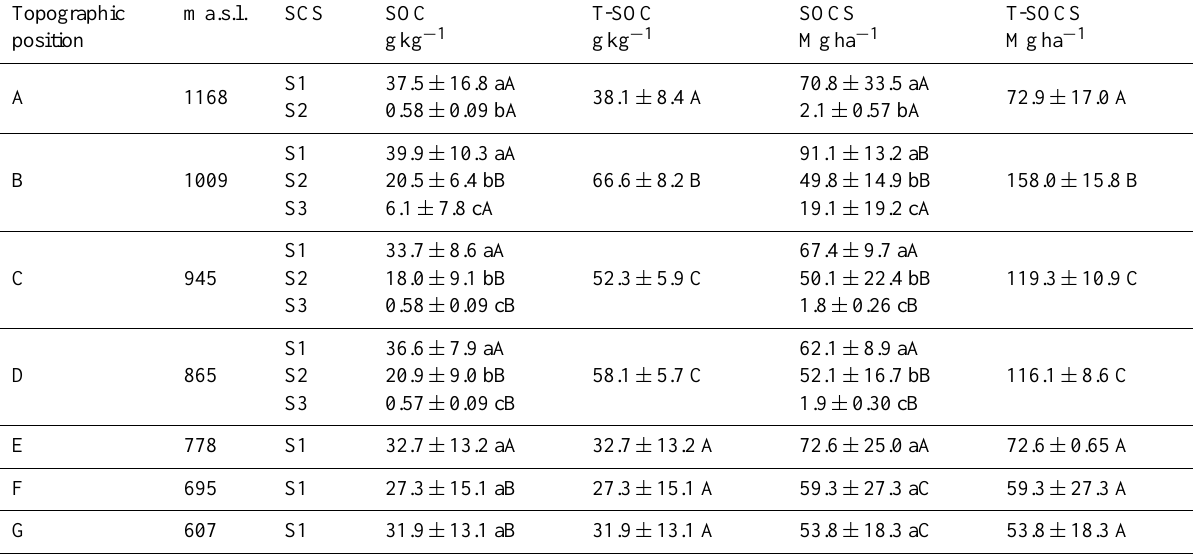
Table 4. Soil organic carbon (SOC) content and soil organic carbon stock (SOCS) (average ± SD ∗ ) in the Despeñaperros Natural Park. Topographic ma.s.l. SCS SOC position